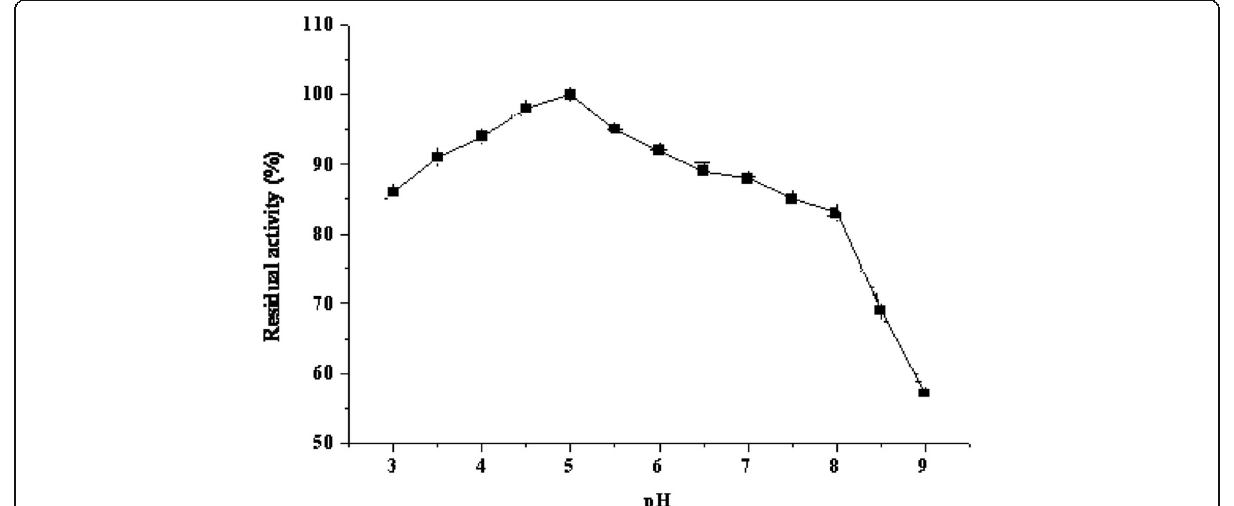
Fig. 4 pH stability of alpha-galactosidase in Penicillium sp.